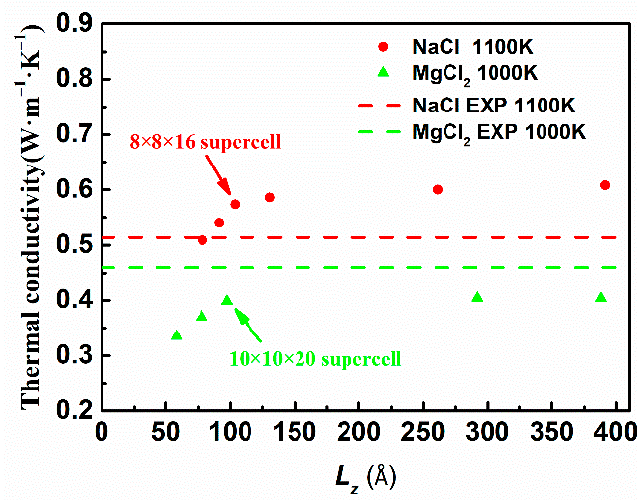
Figure 8. Length dependence of thermal conductivities on L z .